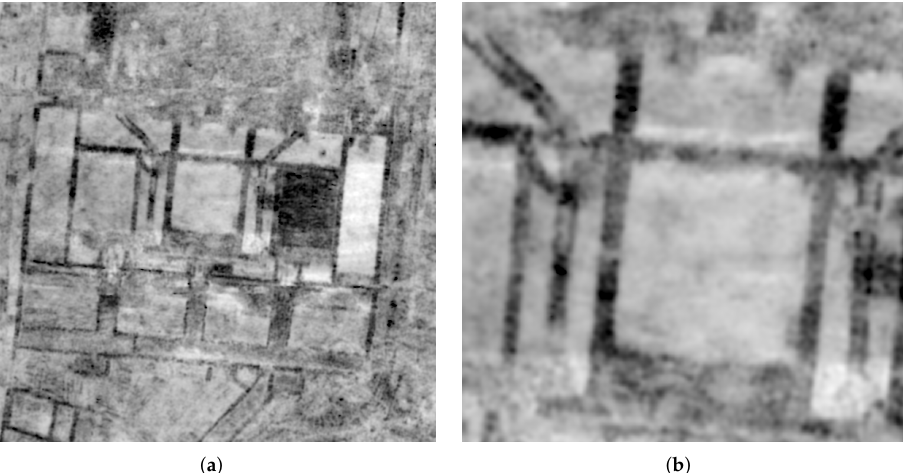
Figure 6. Edge enhancing anisotropic diffusion filter applied to GPR Roman GPR dataset. Similar to the bilateral filter, EED ( a , b ) can depict the outline of the foundation walls in comparison to the unfiltered image in Figure 1. Compared to the median filter result detail view in Figure 5d, blurring of wall boundaries occurs to a lesser extent. Noise in the surrounding soil regions is still removed to a great extent ( b